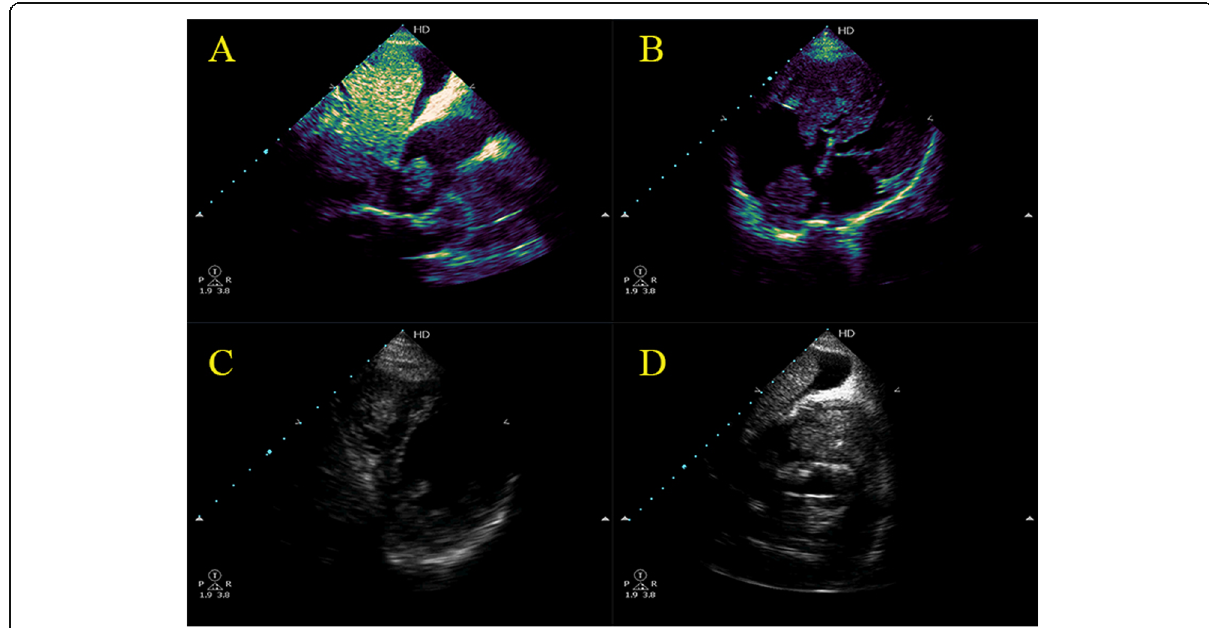
Fig. 1 a – d Transthoracic Echocardiography revealing a large solid mass extending through IVC to RA with another highly mobile cauliflower mass at the RV apex occupying The RV cavity, protruding into RA through TV and nearly obliterating RVOT into the pulmonary